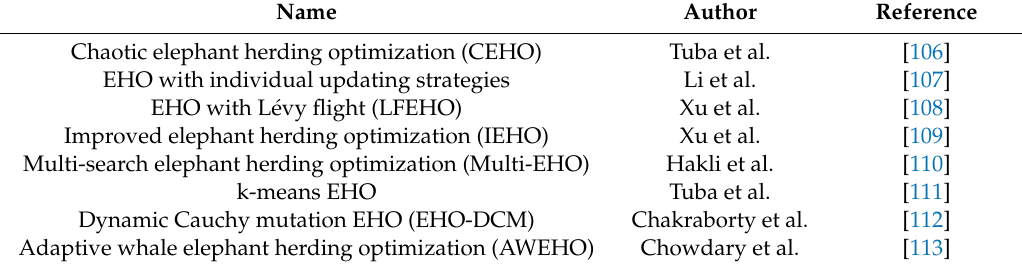
Table 1. The improved EHO algorithms.